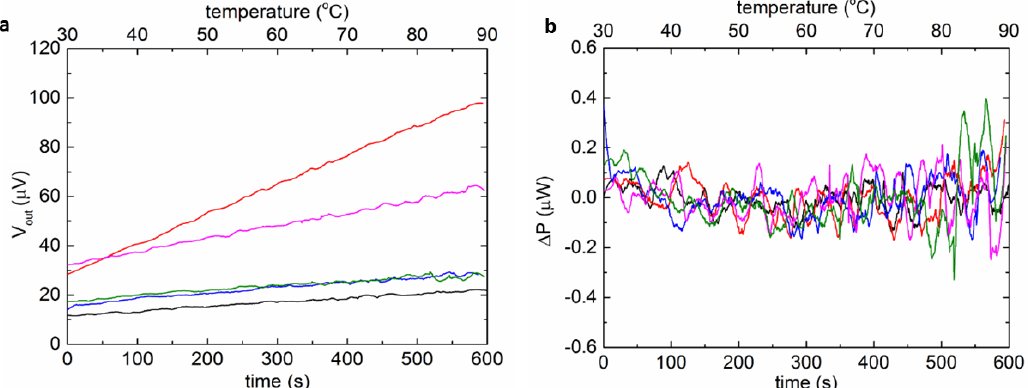
Figure 3. The baseline characterization of the MEMS DSC. ( a ) The raw baselines of the MEMS-based DSC (repeated five times). ( b ) The fluctuation of the baselines upon removing the linear parts.